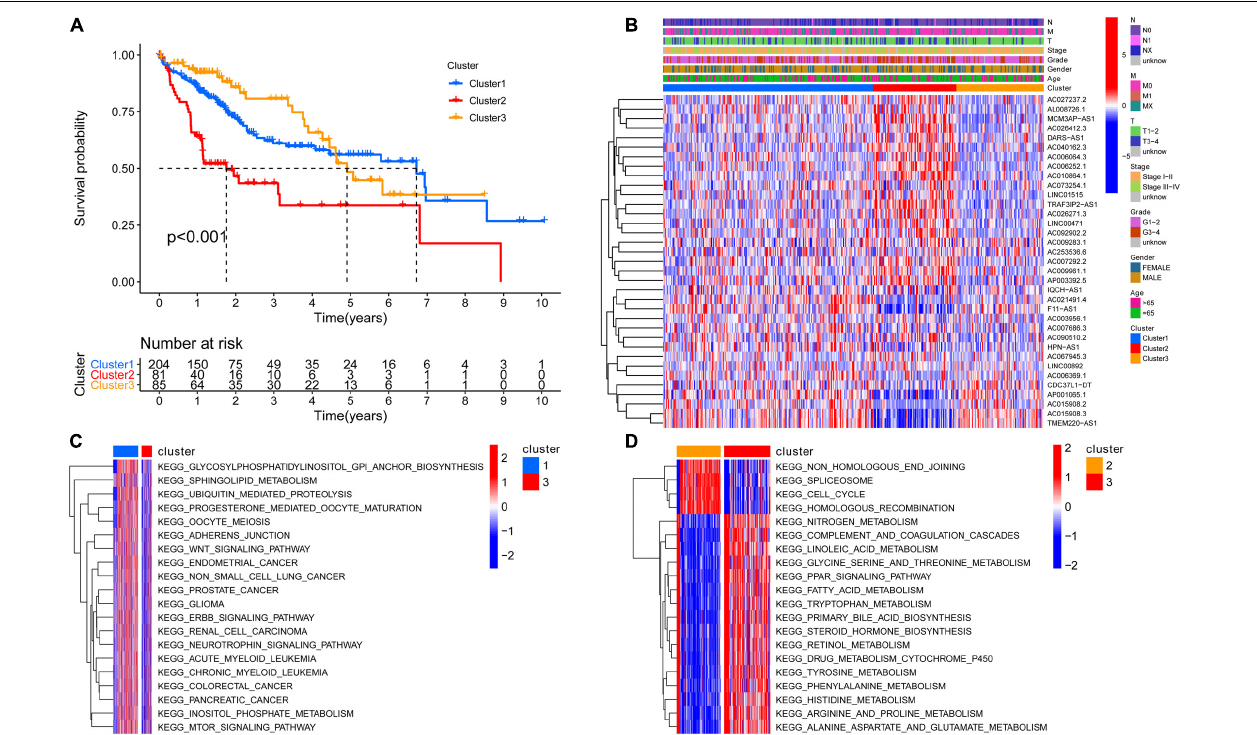
FIGURE 3 | The cluster and biological function based on the expression of 336 differentially expressed lncRNAs. (A) Three different clusters were identified by the unsupervised clustering method, and the cluster 2 model indicated an especially survival disadvantage. (B) The heatmap of the top 20 long non-coding RNAs (lncRNAs) associated with favorable and poor overall survival (OS) and clinicopathological manifestations; the result shows that the expression of lncRNA in cluster 2 is obviously heterogeneous. (C) Cluster 1 was prominently correlated to cancer development, such as glioma and small-cell lung cancer. (D) Cluster 3 was mainly enriched in pathways related to metabolism activation such as fatty acid metabolism, beta alanine metabolism. N, lymph node; N0, the lymph nodes are not affected; N1, the lymph nodes are affected; NX, unevaluated; M, metastasis; M0, no metastasis; M1, metastasis; MX, unevaluated; T, primary tumor.